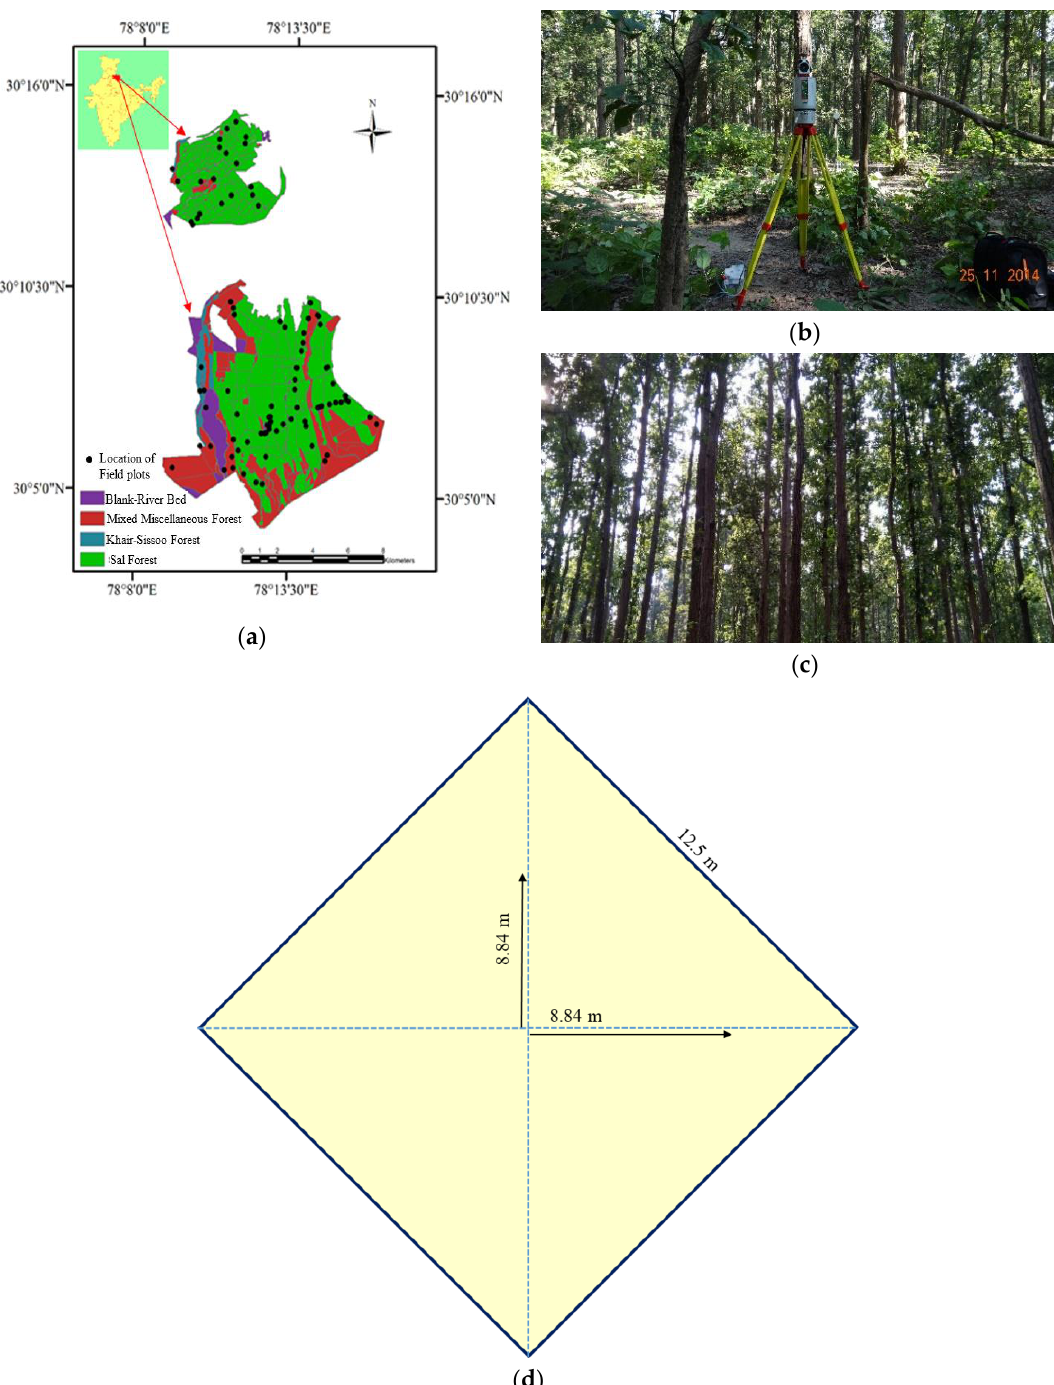
Figure 2. ( a ) Vegetation type map of the forest ranges, ( b ) Terrestrial Lase Scanner (TLS)-based forest height measurement, ( c ) Sal trees, and ( d ) sample plot design.